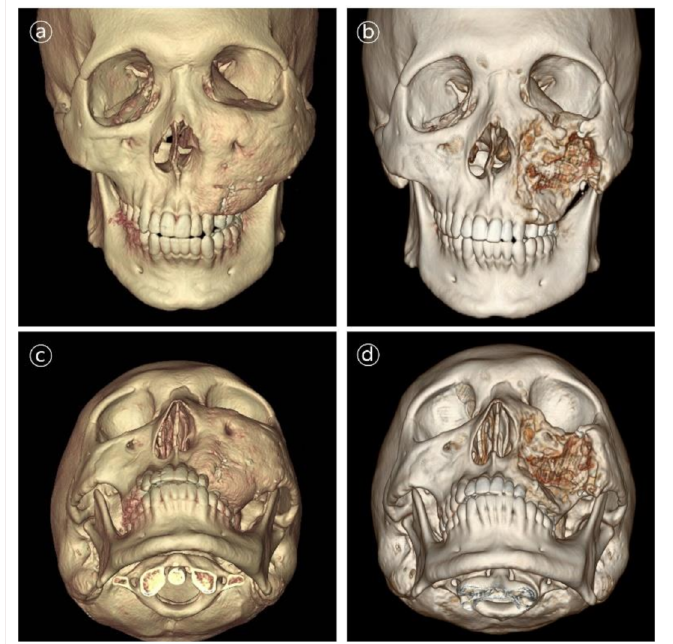
Figure 8. 3D CT images in patient #5. Contour and symmetry of left zygomatico-maxillary region was improved. ( a,b ) Pre- and postoperative 6-month frontal view CT images. ( c,d ) Pre- and postoperative 6-month basal view CT